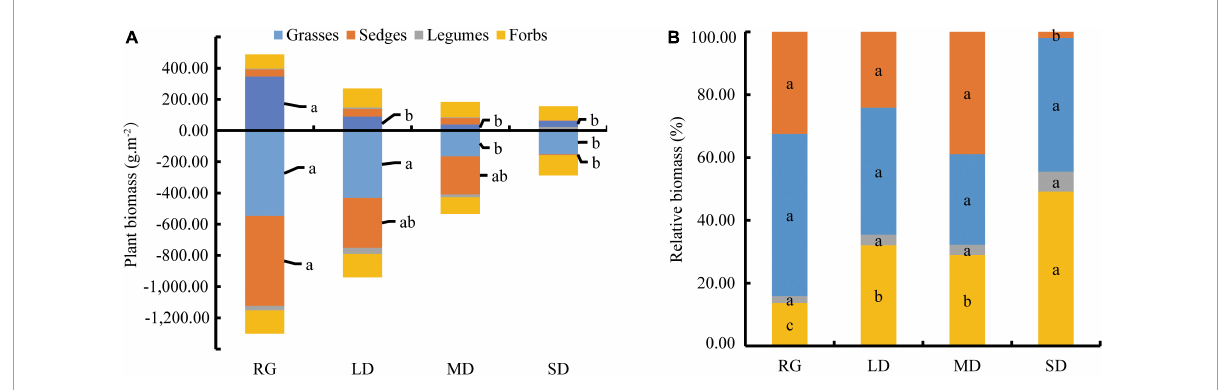
FIGURE2 Biomass (A) and relative biomass (B) of different functional groups. LD, lightly degraded grassland; MD, moderately degraded grassland; SD, severely degraded grassland; RG, reseeded grassland. Different letters indicate significant differences between groups ( P < 0.05).